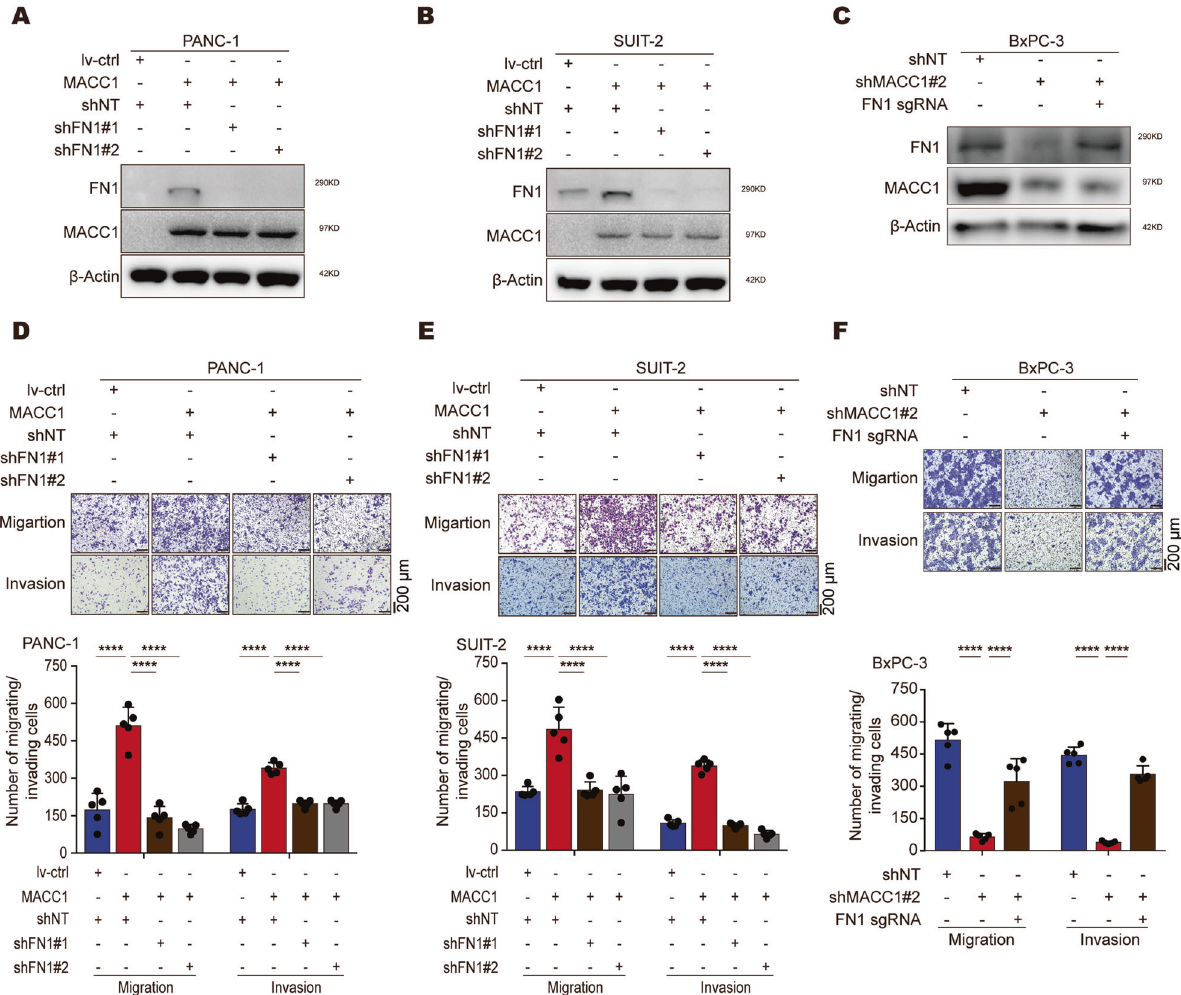
and quanti fi cation of migrated and invaded cells are shown (mean ± SD, n = 5). Scale bars, 200 μ m. One-way ANOVA. **** p < 0.0001. E Migration and invasion of SUIT-2 cells based on MACC1 overexpression and FN1 knockdown. **** p < 0.0001. F Migration and invasion